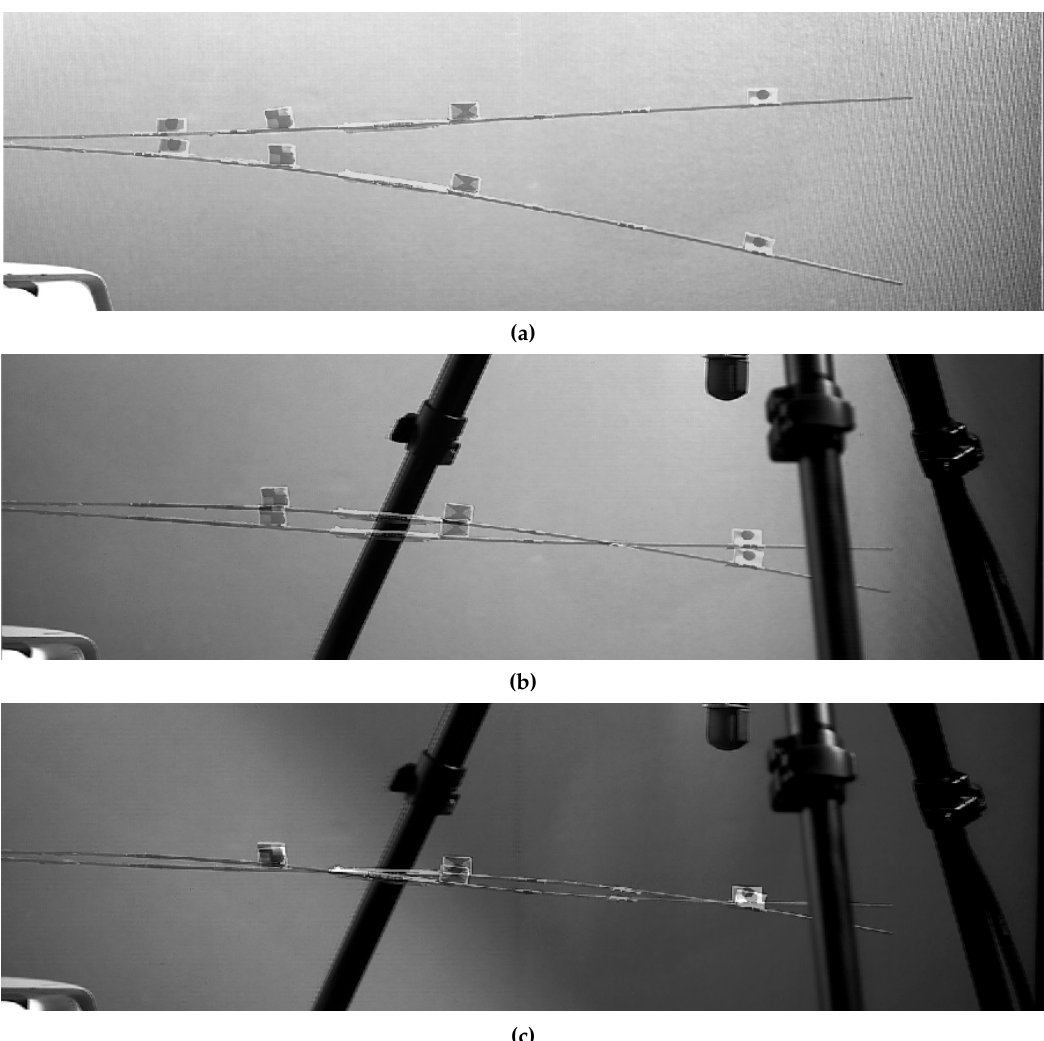
Figure 6. Operational Deflection Shapes corresponding to the first ( a ), second ( b ) and third ( c ) nonlinear normal modes.